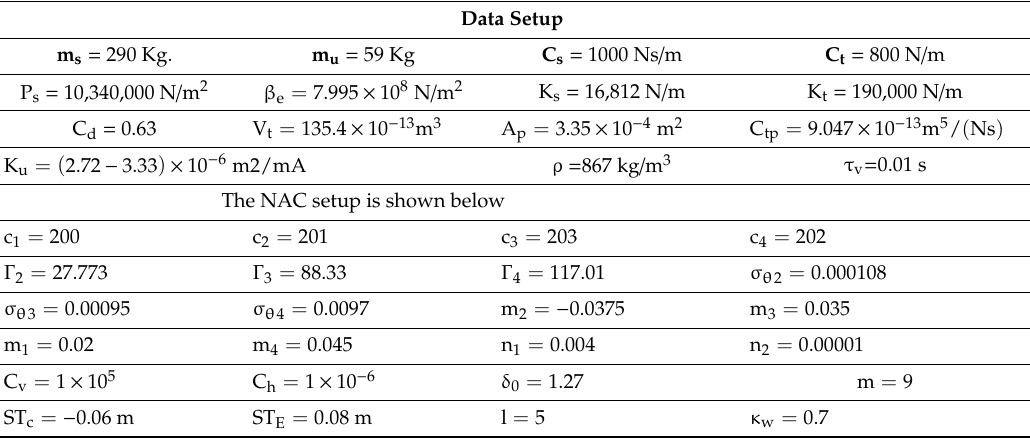
Table 2. Simulation data values of the active suspension mathematical model.